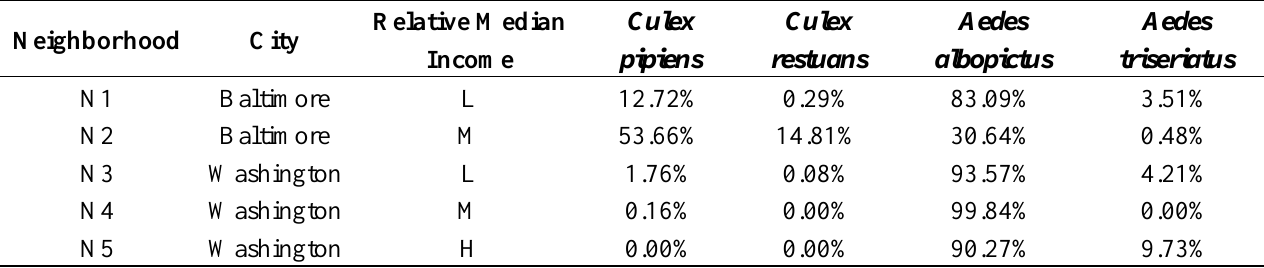
Table 1. Neighborhood classification and mosquito (larvae) species